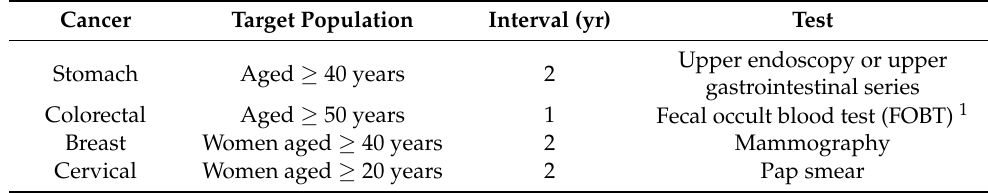
Table 4. Cancer screening protocols issued by the NCSP in